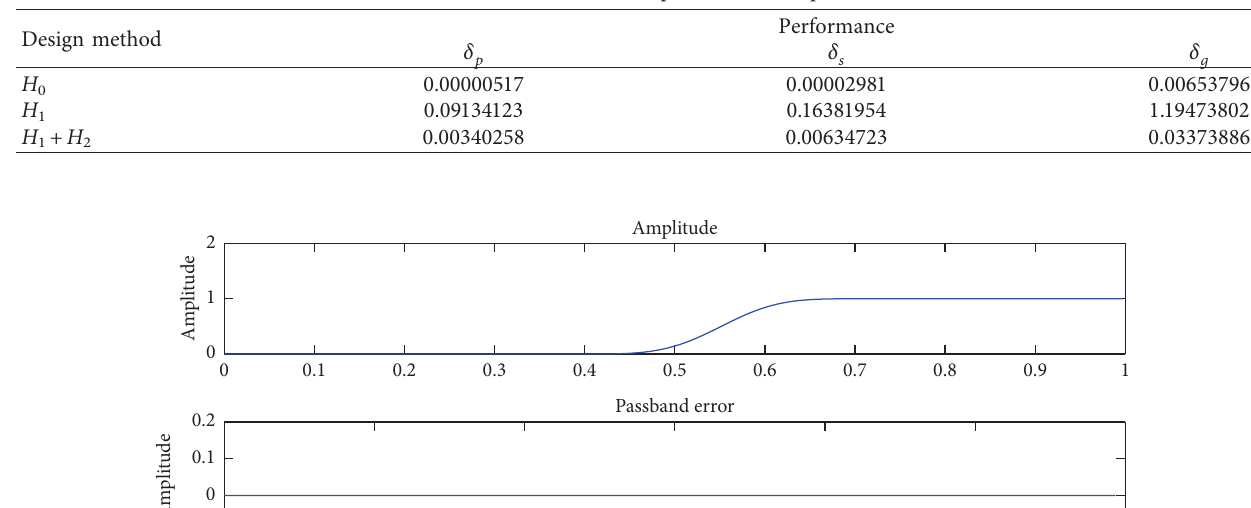
Table 1: Performance comparison in example 1.